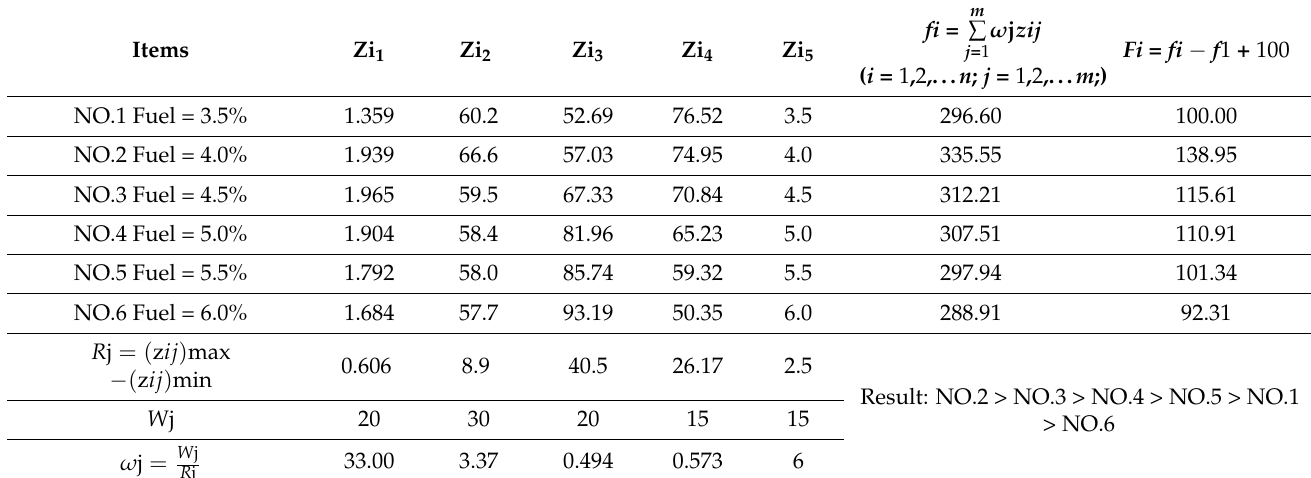
Table 5. Evaluation for the effects of fuel on RVT sinter by comprehensive